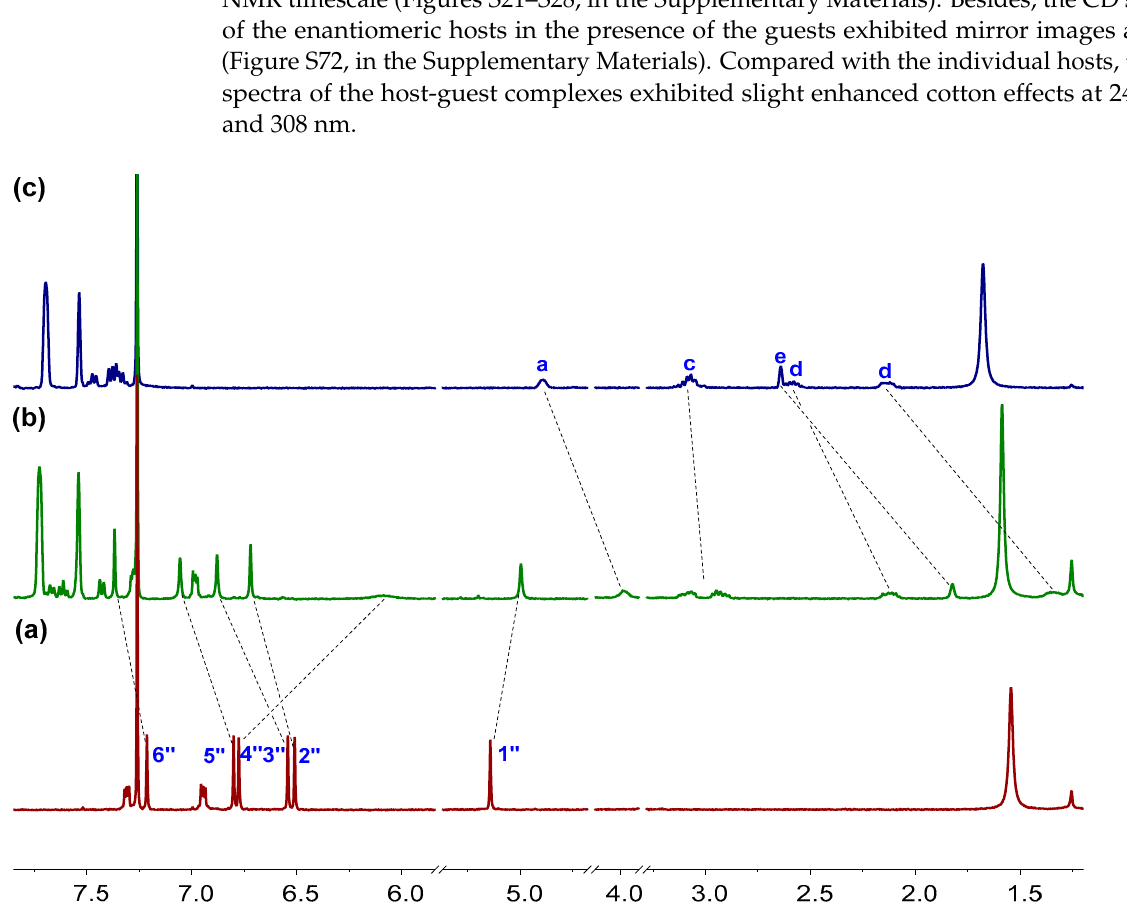
Table 1. Association Constants ( K a /M − 1 ) for 1:1 Complexes Between Chiral H and Chiral G1 – G2 at